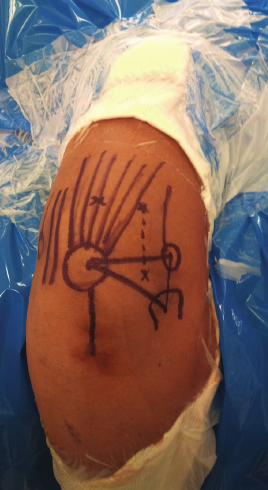
Figure 1: Clinical photograph showing portals for elbow arthro- scopy.